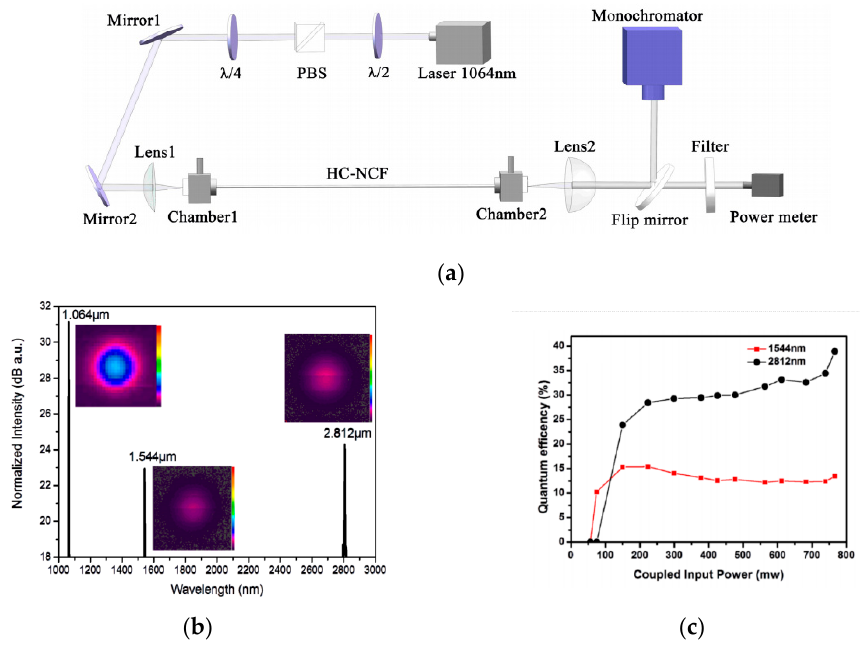
Figure 10. ( a ) Mid-infrared gas Raman laser device. ( b ) When the pressure of methane gas is 1.5 MPa and the pumping power is 381 mW, the Raman spectra obtained are inset for the near field mode at the wavelength of 1064, 1544, and 2812 nm. ( c ) Quantum conversion efficiencies versus the coupled input power at first and second Stokes. Reprinted with permission from [64] © The Optical Society.